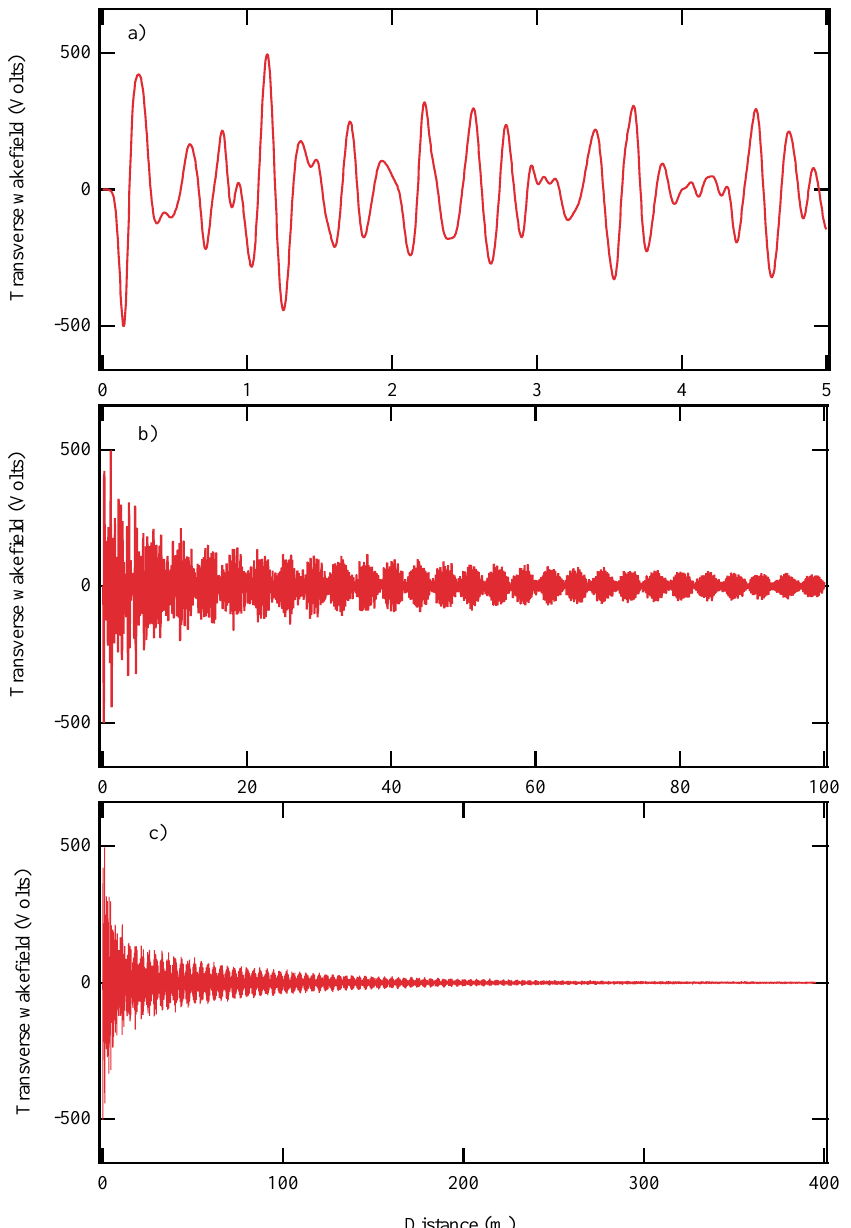
FIG. 2. (Color) Transverse wakefield calculated using MAFIA T3 at 4 cm offset with a 3 cm rms bunch length. (a) Short-range wake, (b) medium-range wake, and (c) long-range